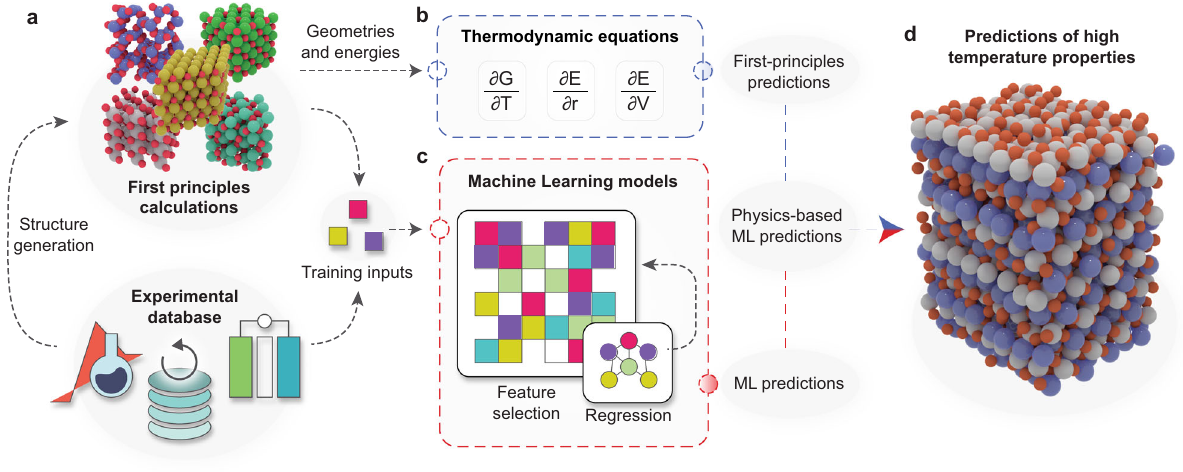
Fig. 1 Hybrid model for predicting high-temperature properties of metal oxides. a Zero Kelvin fi rst-principles calculations and fi nite-temperature experimental data of metal oxides from the literature are compiled in a database. b Thermodynamic quantities are evaluated from fi rst principles where feasible. c Features are extracted from the data set and used as inputs to build a quantitative machine learning (ML) model for those contributions that are not accessible from fi rst principles. d The output from the ML model and from fi rst-principles calculations together enter a physics-based framework for the prediction of the temperature-dependent stability of other metal oxides that were not included in the reference data